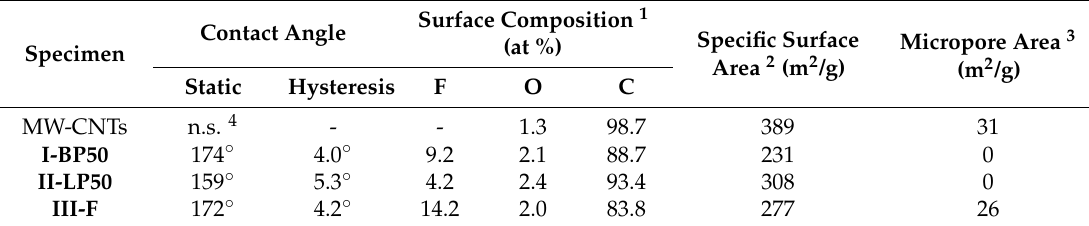
Table 1. Static and hysteresis contact angle measurements with water, surface composition (at %), specific surface area, and micropore area of MW-CNTs before and after PFPE-functionalization ( I-BP50 , II-LP50 ) and fluorination ( III-F ).